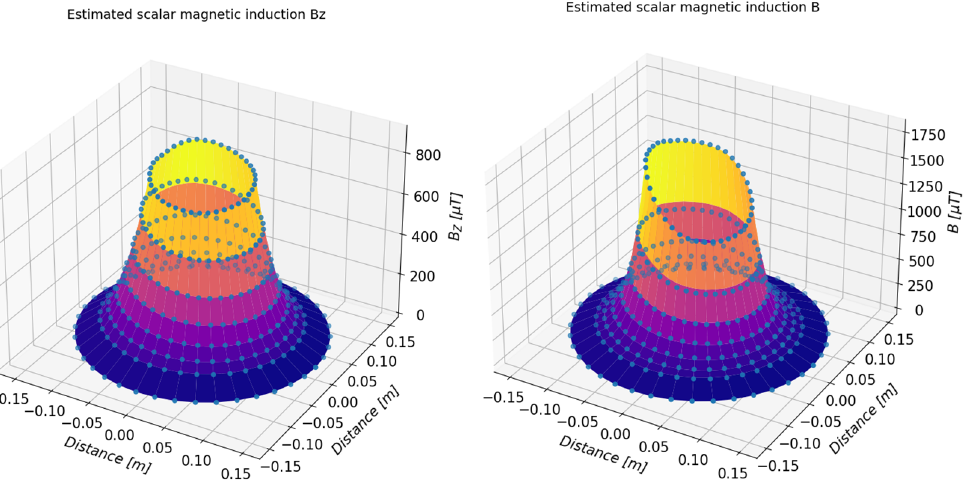
Figure 20. Three-dimensional presentation of the estimated value of the component B z ( left ) and total value B ( right ) of the magnetic induction of the examined magnets determined on the basis of the measurements. Table 3. Estimated values of the B x component of magnetic induction as a function of rotation angle and measurement distance.